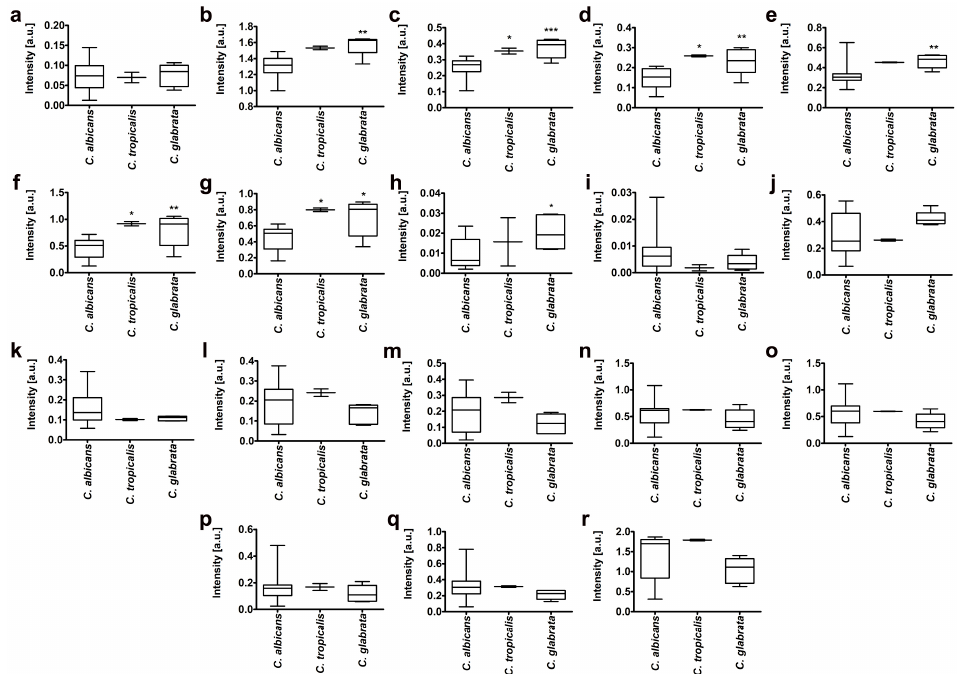
Figure 5. A comparative analysis of differences in the intensities of some FTIR ( a – k ) and Raman ( l – r ) vibrations between C. albicans group (1, 2, and 4–19), C. tropicalis group (20, 21), C. glabrata group (3 and 22–25), reference strain group (haploid, 26; diploid, 27; and tetraploid, 28); a.u., arbitrary units. ( a ) C-O, C-O-H, and C-O-C deformation and C–C stretching vibrations from carbohydrates,